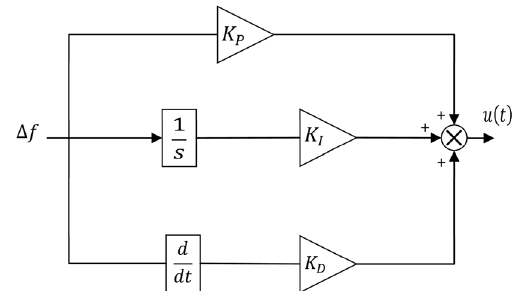
Fig. 13 Schematic of the PID controller